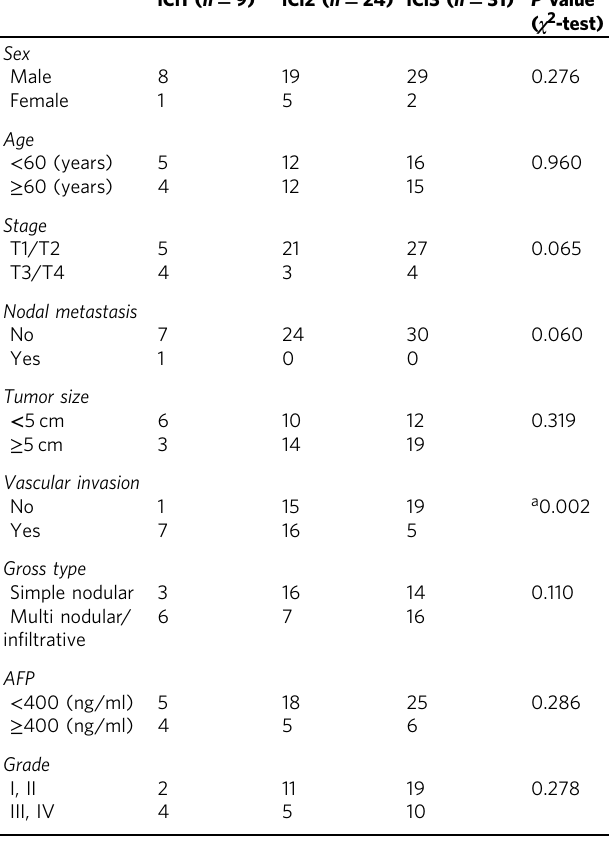
Table 1 Clinico-pathological features of the molecular subtypes of SNU